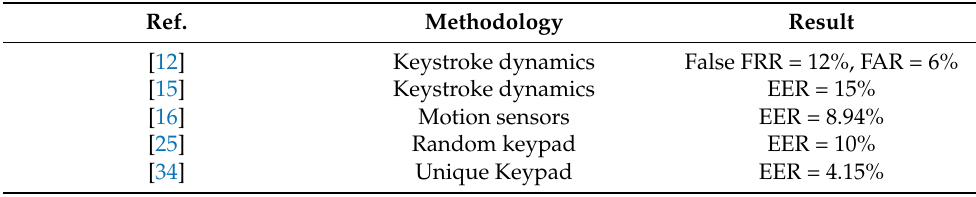
Table 1. Summary of the relevant articles published in the literature.